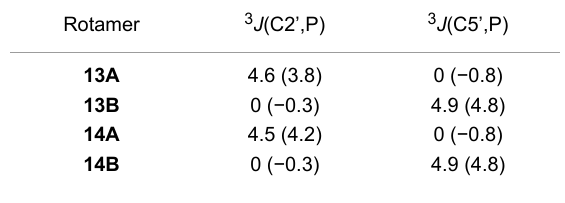
Table 1: The comparison of the observed and calculated (in paren- theses) 3 J (C2’,P) and 3 J (C5’,P) for rotamers 13A,B and 14A,B